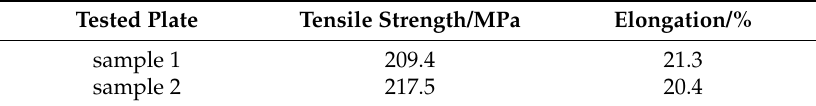
Table 3. The results of the tensile strength test.